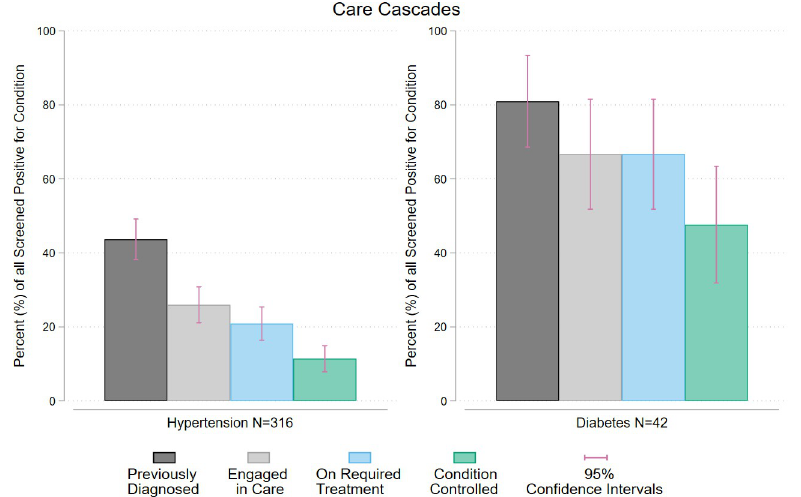
Fig 2. Care cascade for hypertension or diabetes, showing the percentage of all people who screened positive for the condition in each of the levels of the cascade: diagnosed, engaged in care, retained on treatment including lifestyle changes and pharmaceutical interventions, and controlled.